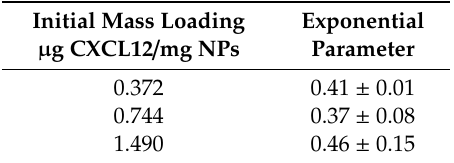
Table 2. Korsmeyer-Peppas model parameter estimation ( ± STD).